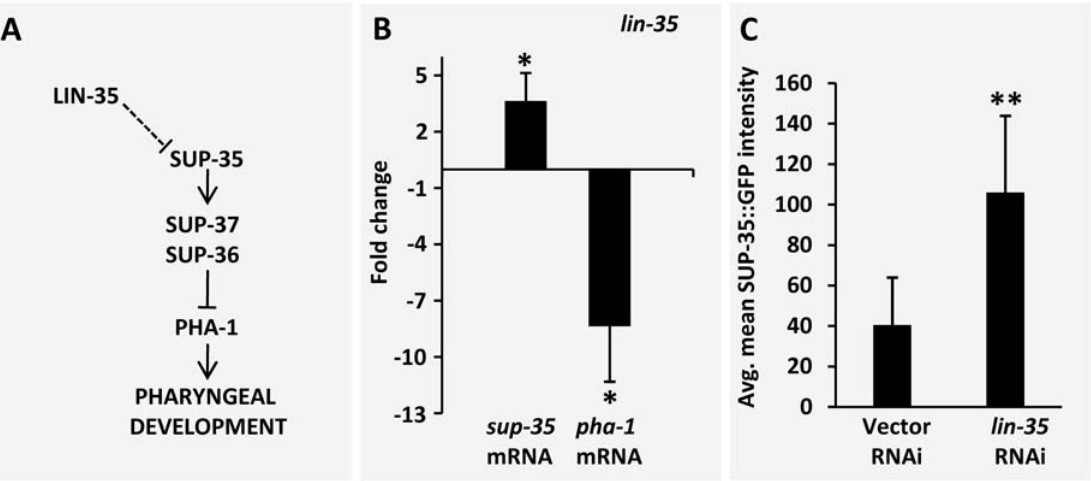
Figure 6. Regulation of sup-35 and pha-1 by LIN-35. (A) Testable model for the regulation of SUP-35 and PHA-1 by LIN-35. (B) Quantification of endogenous sup-35 and pha-1 mRNA levels in embryos by qRT-PCR in lin-35 mutants using act-1 as an internal normalization control. Fold changes were obtained after normalizing to N2. Note that consistent with sup-35 mRNA upregulation in lin-35 mutants, pha-1 mRNA is significantly downregulated. (C) Quantification of SUP-35::GFP protein levels in embryos following RNAi inhibition of lin-35 (also see Figure S1). Animals assayed were of genotype pha-1(e2123); sup-36(e2217); fdEx57 (SUP-35:: GFP ) embryos of the genotype pha-1(e2123); sup-37(e2215); fdEx63 (SUP-35:: GFP showed similar trends (data not shown). Error bars represent s.e.m. The means of the indicated groups were analyzed for significance using a two- tailed Student’s t-test. *p , 0.05 and **p , 0.0001.